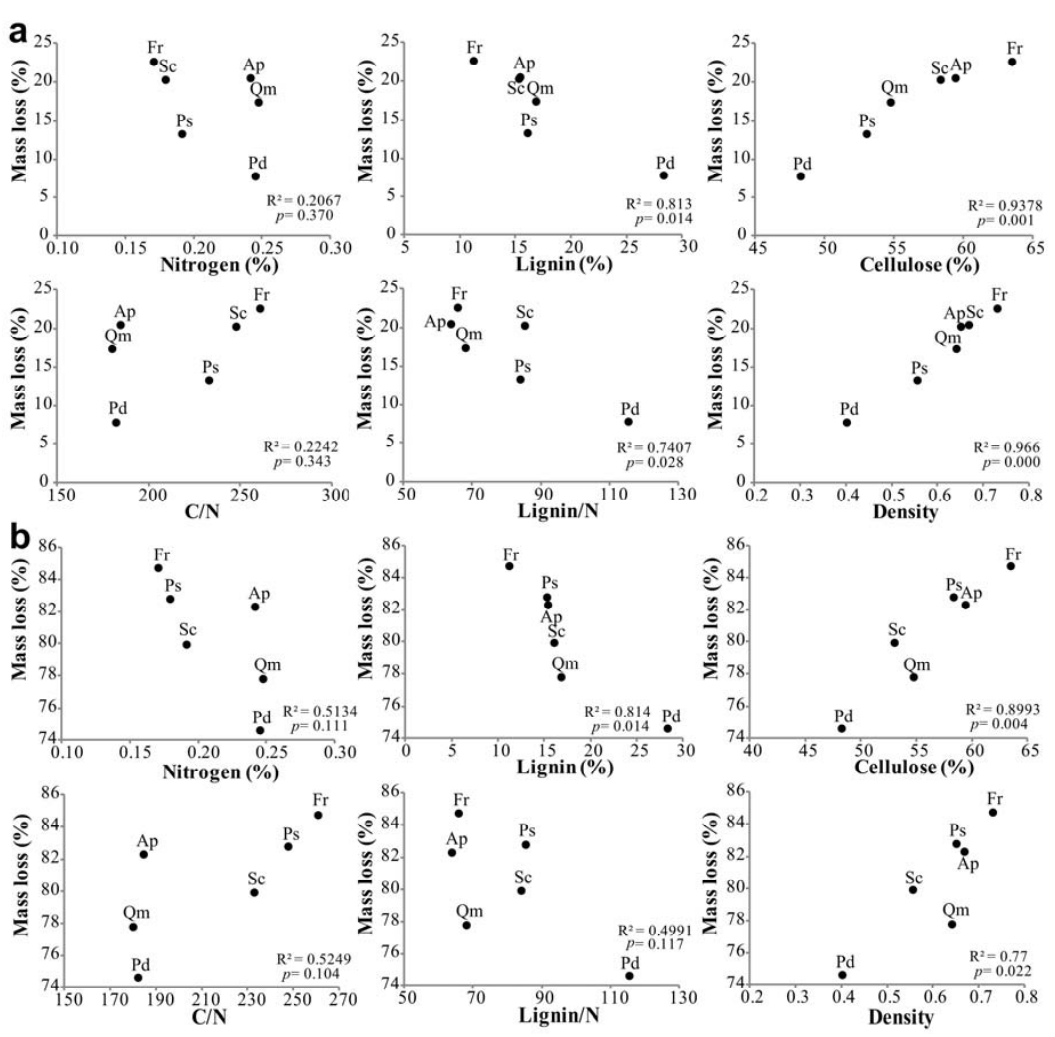
Figure 3. Linear regression of branch wood mass loss on initial chemical and physical factors for six tree species ( a ) during the early stage of decomposition (from the beginning of decomposition to 9 months) and ( b ) during the entire decomposition period of 40 months ( n = 5). Ap ( A. pseudosieboldianum ), Fr ( F. rhynchophylla ), Pd ( P. densiflora ), Ps ( P. sargentii ), Qm ( Q. mongolica ) and Sc ( S. chinensis ).